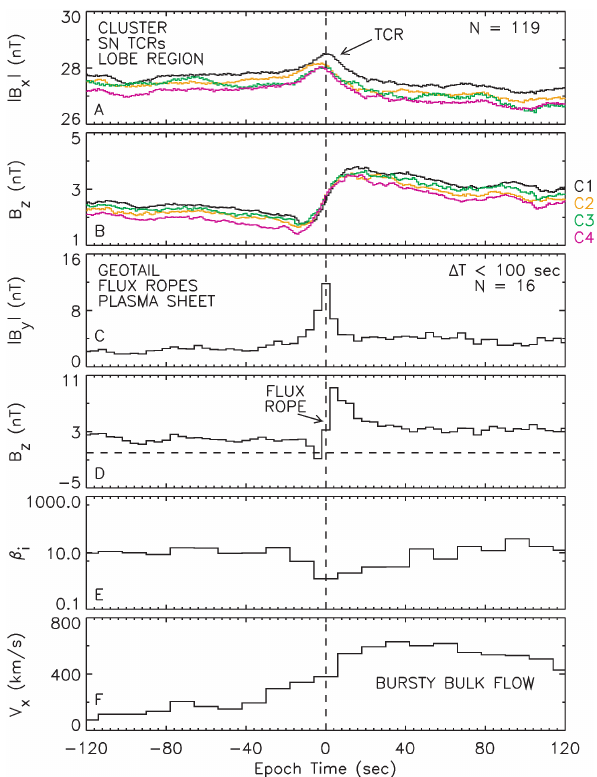
Fig. 9. Merged superposed epoch analyses of Cluster SN TCRs and Geotail BBF-type flux ropes. (From Slavin et al., 2005).